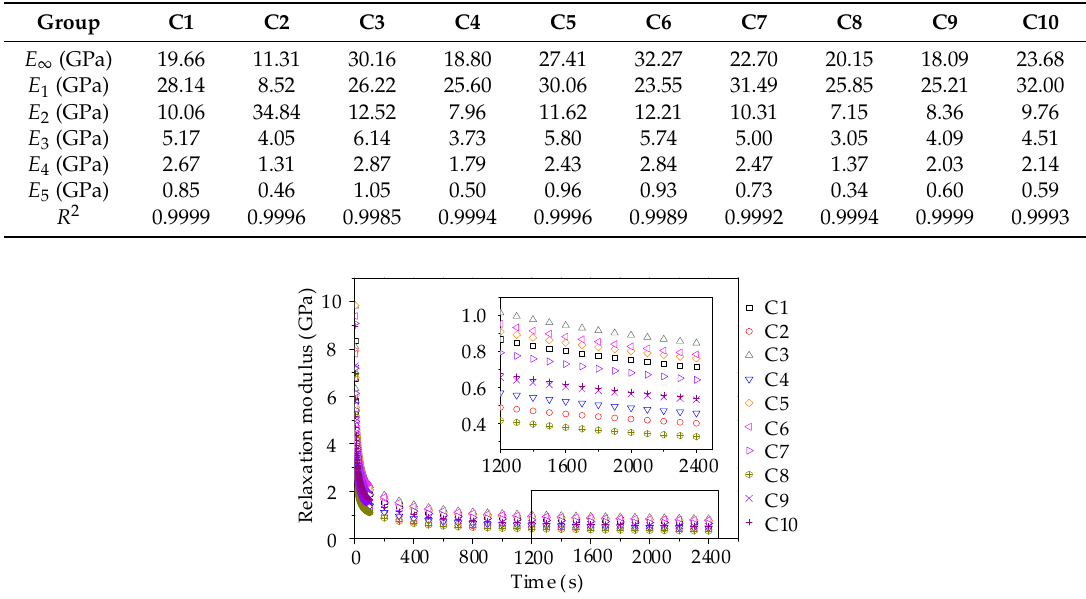
Table 9. Fitting results of Prony series for asphalt mixtures.